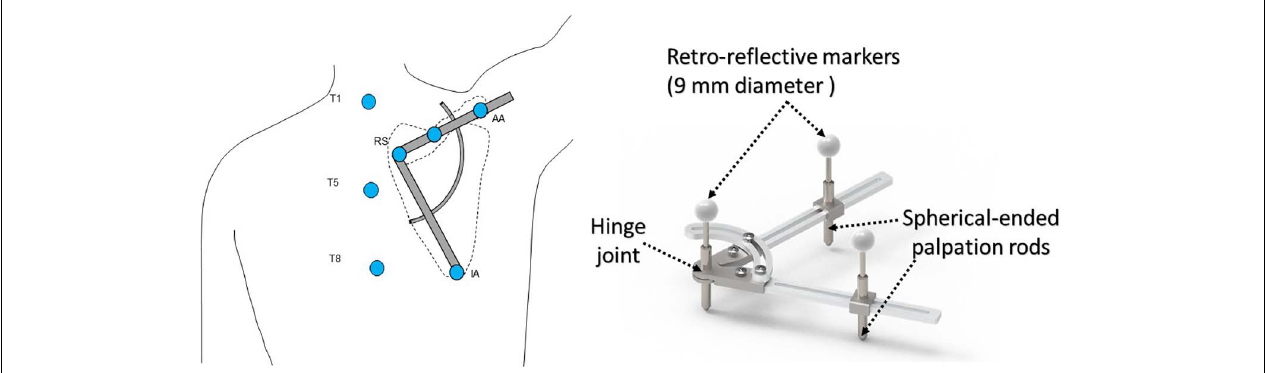
FIGURE 2 | Schematic diagram showing a subject with the scapular locator to measure the scapular kinematics during arm elevation in the scapular plane. The palpation rods were adjusted to fit over the root of the scapular spine (RS), the acromial angle (AA), and the inferior angle (IA) of the scapula. Infrared retro-reflective markers were also attached to the bony landmarks of the trunk, namely the spinal process of the 1st (T1), the 5th (T5), and the 8th thoracic vertebra (T8).